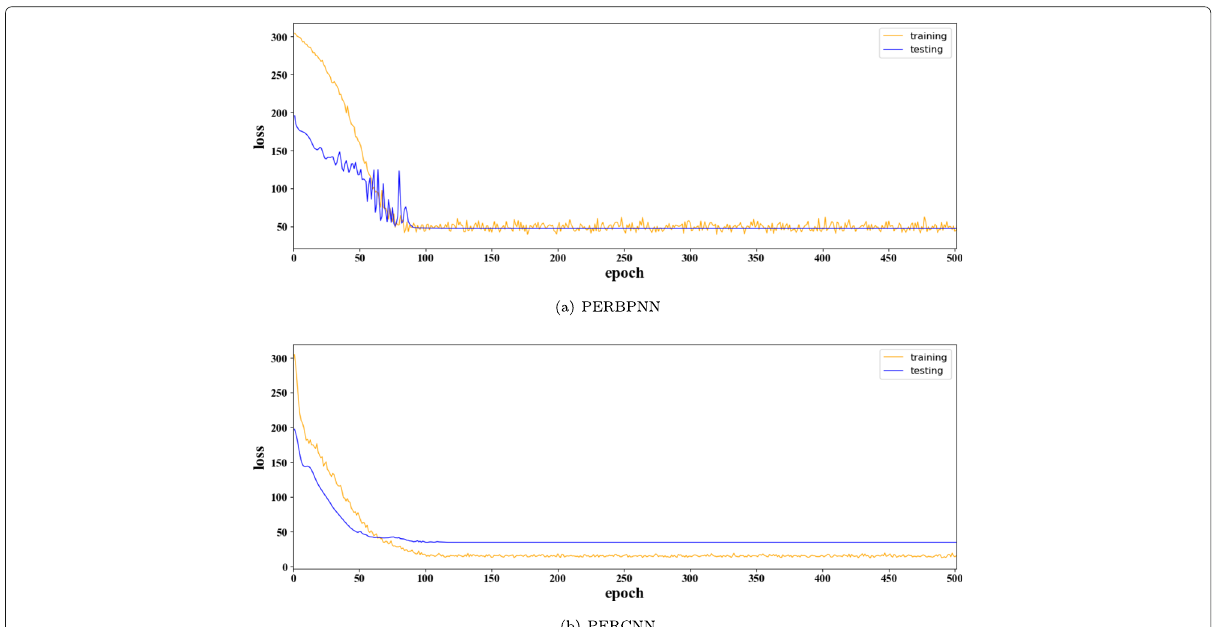
Fig. 6 The loss of PERBPNN and